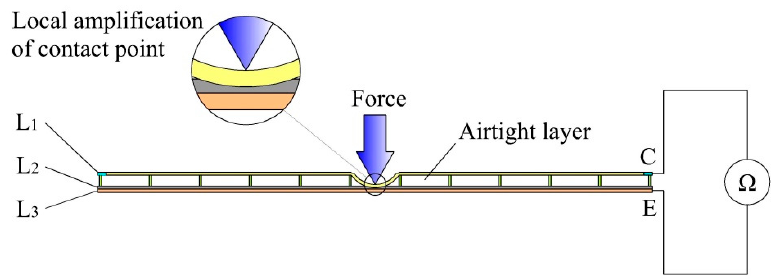
Figure 6. The schematic diagram of contact force detection.